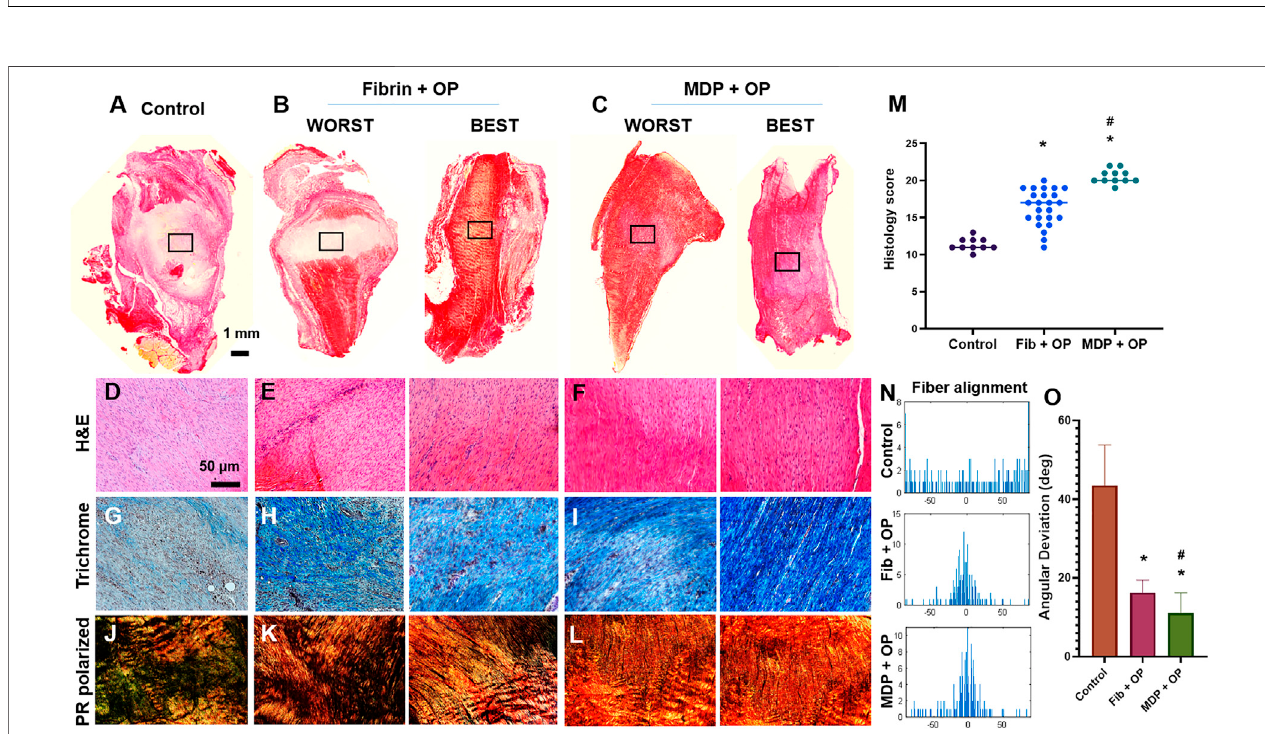
FIGURE 3 | In vivo tendon healing by 2 weeks. The control ended up with scar-like healing with disrupted matrix and high cellularity (A – D) . In contrast, fi brin and MDP delivered with Oxo-M and 4-PPBP showed notable improvement in tendon healing (B – F) . Masson ’ s trichrome showed higher collagen deposition in the healing zone with Oxo-M and 4-PPBP delivery via fi brin and MDP (G – I) . Polarized PR images showed higher collagen orientation with MDP + OP than fi brin + OP (J,K) . There were some variances in the healing outcome with fi brin + OP (B – K) compared to a more consistent outcome with MDP + OP (C – L) . Quantitatively, MDP + OP resulted in signi fi cantly higher histological scores with a relatively small variance as compared to Fib + OP (M) ( n = 10 – 25 per sample; *: p < 0.001 compared to control; p < 0.001 compared to Fib + OP). Digital imaging processing shows a narrow distribution of fi ber orientation angels in MDP + OP and Fib + OP compared to the spread histogram in control (N) . Quantitative angular deviation (AD) value was signi fi cantly lower with MDP + OP as compared to fi brin + OP and control (O) (*: p < 0.0001 compared to control; #: p < 0.001 compared to Fib + OP; n = 10 – 15 per group). All images are representative best outcome for each group.